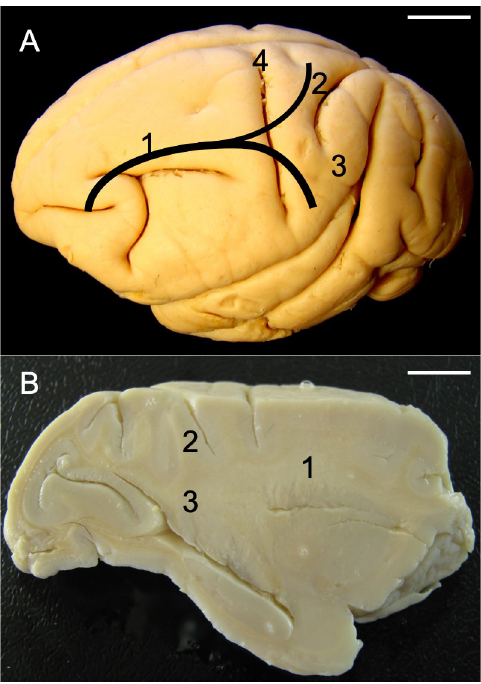
Fig 6. Photograph of right (lateral view) (A) and left (medial view) (B) hemispheres of Sapajus sp. (A) [1] cingulate and longitudinal fascicles in a same bundle; [2] individualized longitudinal fascicle; [3] individualized cingulate fascicle. Note the identical disposition, pathway and distribution of the fibers. (B) [1] Cingulate and longitudinal fascicles in a same bundle; [2] Individualized longitudinal fascicle; [3] Individualized cingulate fascicle. [4] Corpus callosum; [6] Thalamus; [7] Frontal pole; [8] Occipital pole; [9] Central sulcus; [10] Lateral sulcus; [11] Lunatus sulcus; [12] Post-central sulcus; [13] Superior temporal sulcus; [14] Vertical sulcus; [15] Occipital-temporal sulcus; [16] Calcarine sulcus. Specimens: (A) adult male; (B) adult female. Bar = 1 cm.